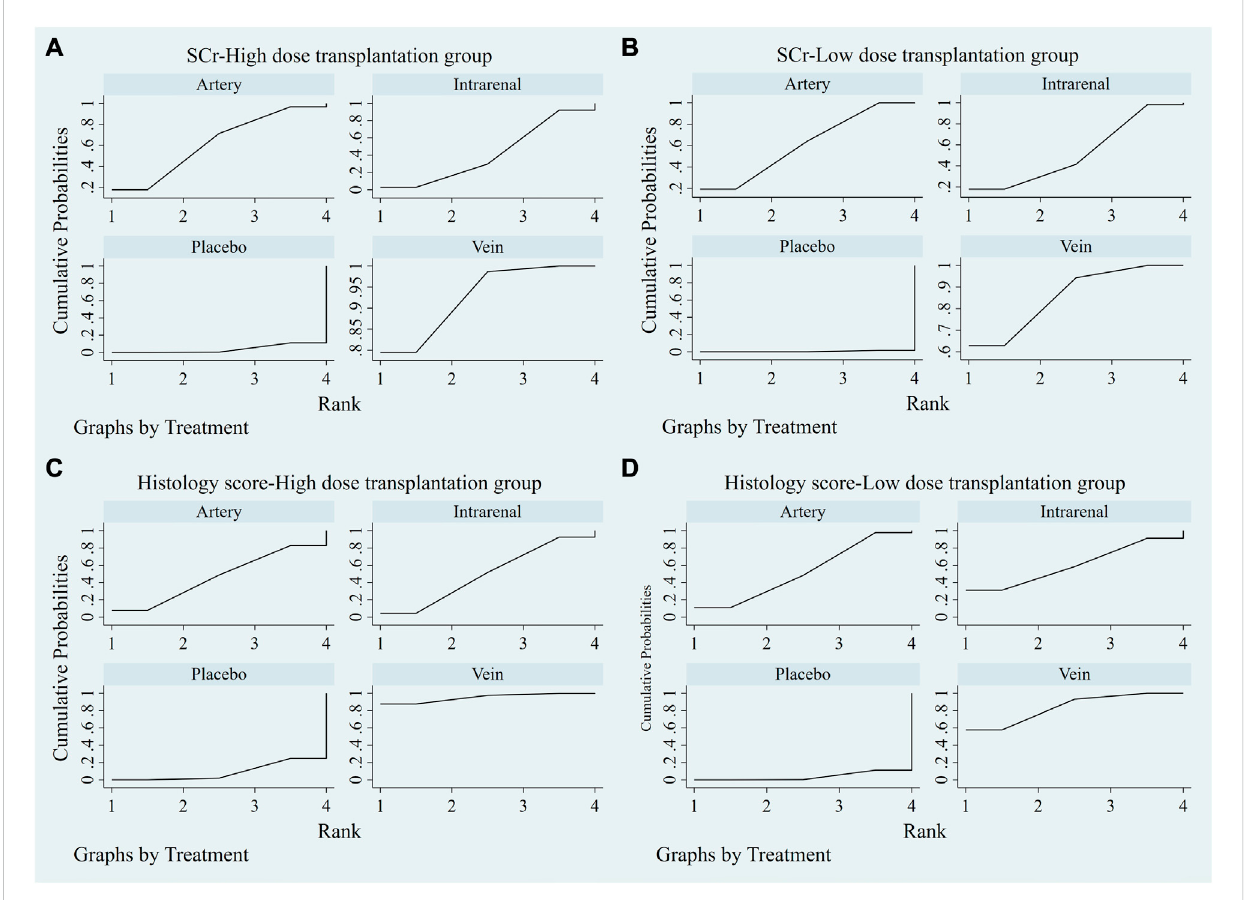
FIGURE 4 SUCRA plot of different transplantation routes. (A) SCr-High dose transplantation group. (B) SCr-Low dose transplantation group. (C) Histology score-High dose transplantation group. (D) Histology score-Low dose transplantation